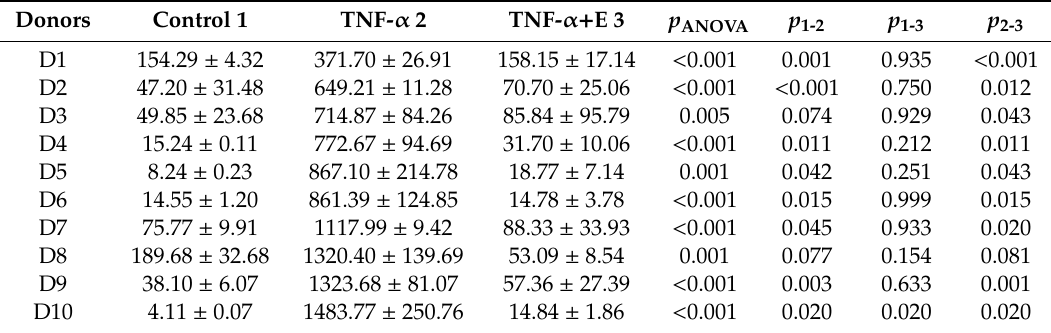
Table 1. ILl-6 expression by cells from di ff erent